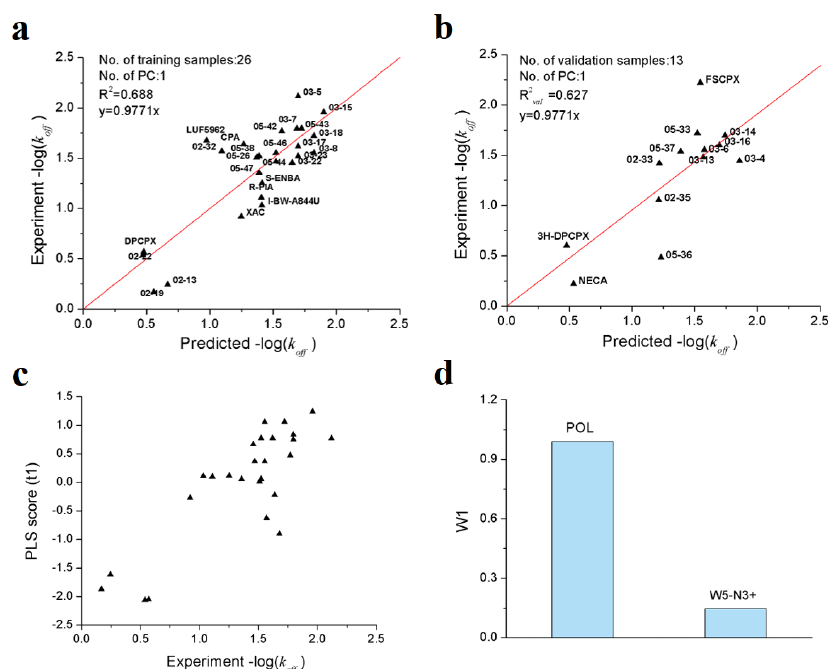
Figure 5. Optimal PLS model of the dissociation rate constants of 39 A1AR agonists/antagonists. ( a ) scatter plot of experimental vs. predicted −log( k off ) of the 26 training samples; ( b ) scatter plot of experimental vs. predicted −log( k off ) of the 13 validation samples; ( c ) first principle component scores of the 26 training samples; ( d ) weights of independent variables in the first principle component.